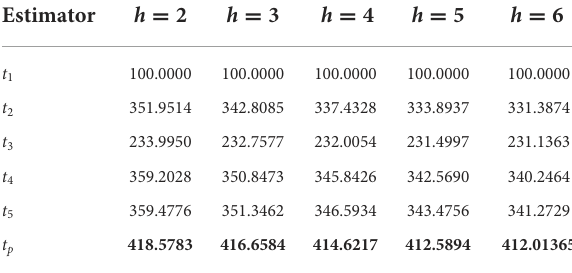
TABLE 5 PRE of different estimators with respect to t 1 for Population 4.